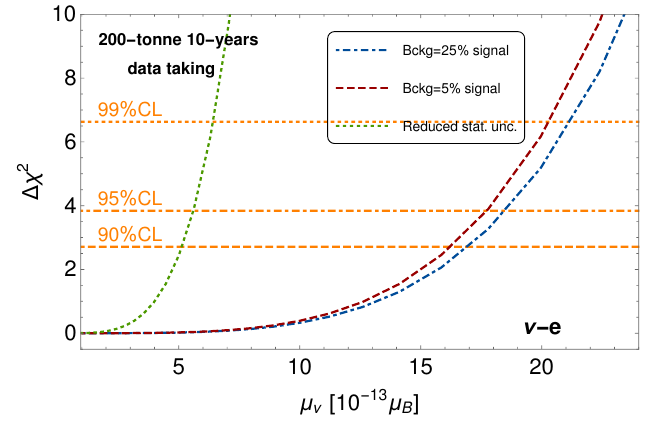
Figure 5 . Electron recoil sensitivities to neutrino magnetic dipole moments in a 200-tonne liquid xenon detector under the background 2 and background 3 hypotheses ( 25% and 5% of the sig- nal rate) assuming 100% detector efficiency. Results from an analysis with a reduced statistical uncertainty are given by the dotted green curve. The result is obtained for 10 years of data